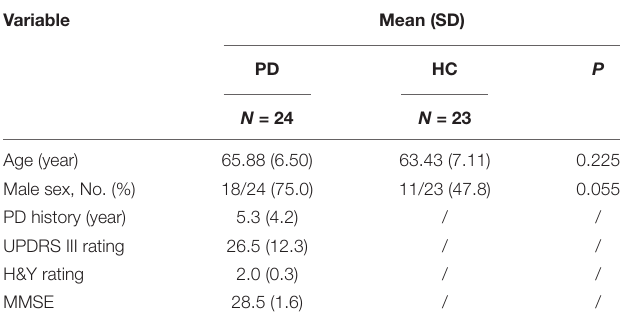
TABLE 1 | Demographic characteristics of all enrolled